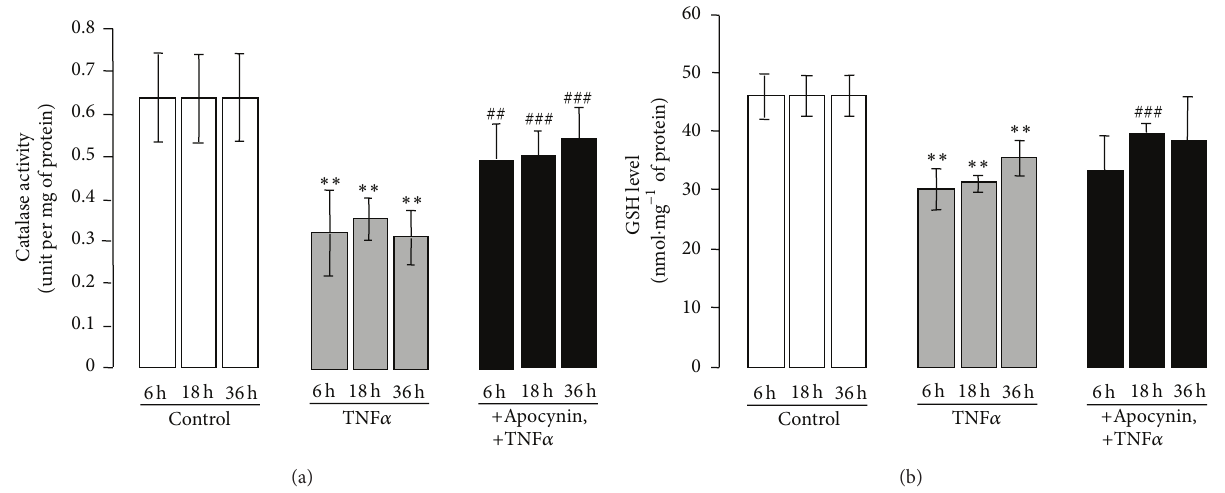
Figure 7: TNF 𝛼 -induced colitis results in a decrease of endogenous antioxidants in the colon, an effect that is prevented by apocynin. (a) Catalase activity was assayed in fresh colon tissues of mice treated with TNF 𝛼 (10 𝜇 g ⋅ kg −1 , ip) in the presence or absence of apocynin (25 mg ⋅ kg −1 , ip) as described in Section 2. Data are expressed as means ± S.E.M from 𝑛 = 5 mice in each group. ∗ 𝑃 < 0.05 , ∗∗ 𝑃 < 0.01 , and ∗∗∗ 𝑃 < 0.001 versus control; # 𝑃 < 0.05 , ## 𝑃 < 0.01 , and ### 𝑃 < 0.001 versus TNF 𝛼 ; (b) GSH contents were assayed in fresh colon tissues of mice treated with TNF 𝛼 (10 𝜇 g ⋅ kg −1 , ip) in the presence or absence of apocynin (25 mg ⋅ kg −1 , ip) as described in Section 2. Data are expressed as means ± S.E.M from 𝑛 = 5 mice in each group. ∗ 𝑃 < 0.05 , ∗∗ 𝑃 < 0.01 , and ∗∗∗ 𝑃 < 0.001 versus control; # 𝑃 < 0.05 , ## 𝑃 < 0.01 , and ### 𝑃 < 0.001 versus TNF 𝛼